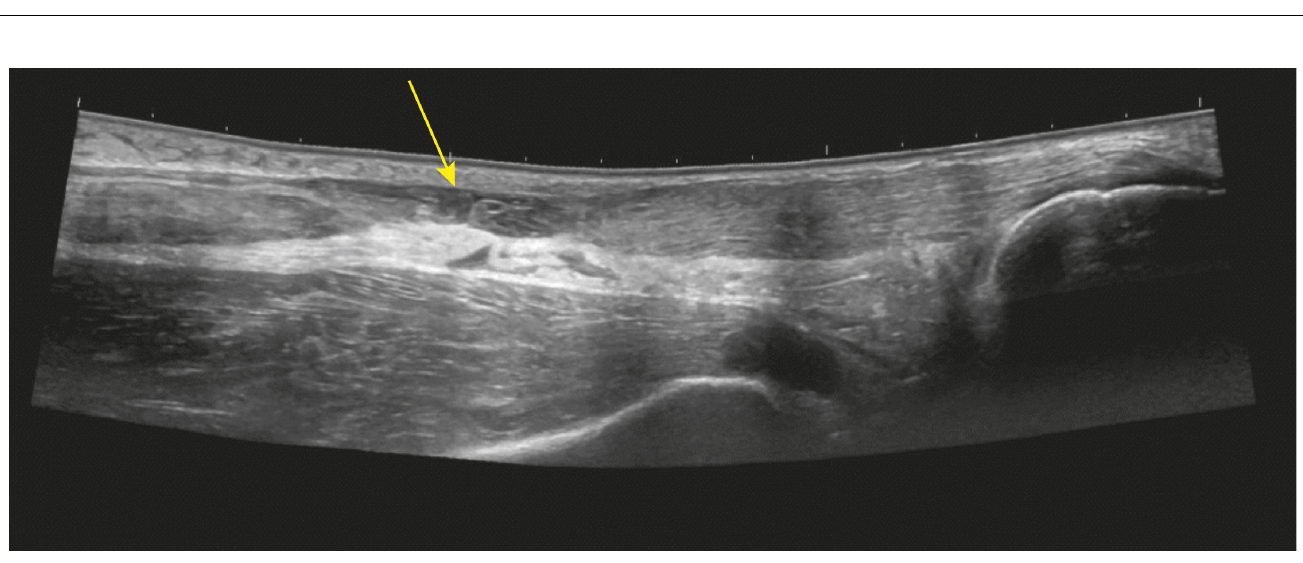
Figure 2. Hospital ultrasound sagittal view of the Achilles